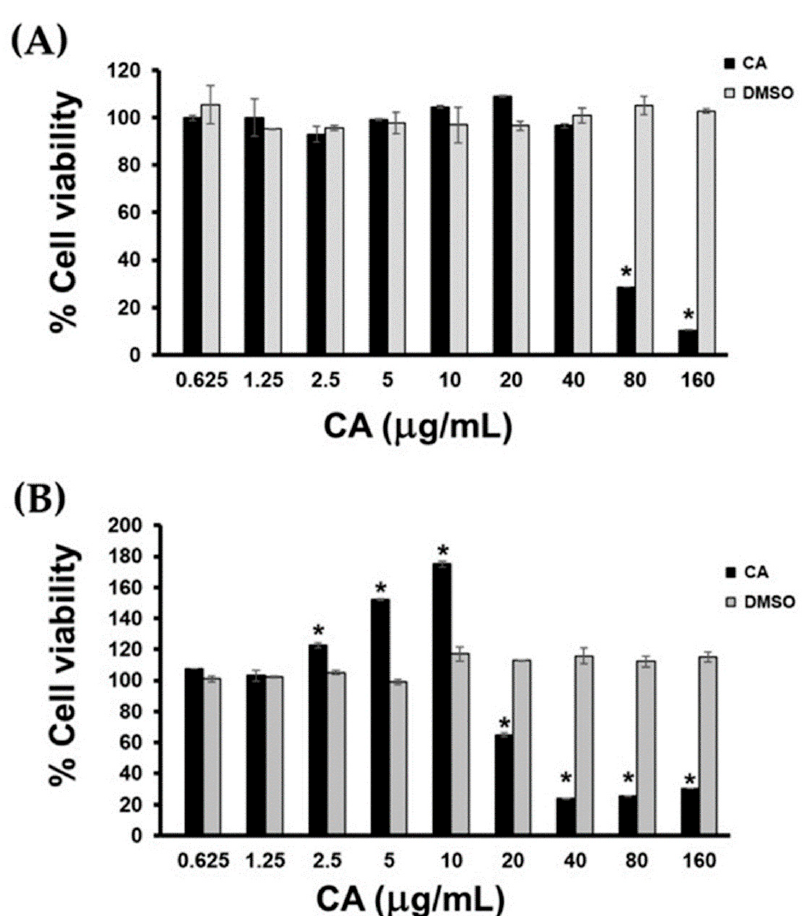
Figure 2. Cell viability HaCaT cells upon treatment with Curcuma amarissima (CA) extract. Viability of HaCaT cells treated with CA extract (0.625 to 160 µ g/mL) or DMSO (0.000625–0.16%) for 48 h in FBS-rich media ( A ) and in FBS-free media ( B ). Data from three experiments were analyzed and presented as mean ± standard deviation (SD); * p < 0.05 in comparison to the untreated group .